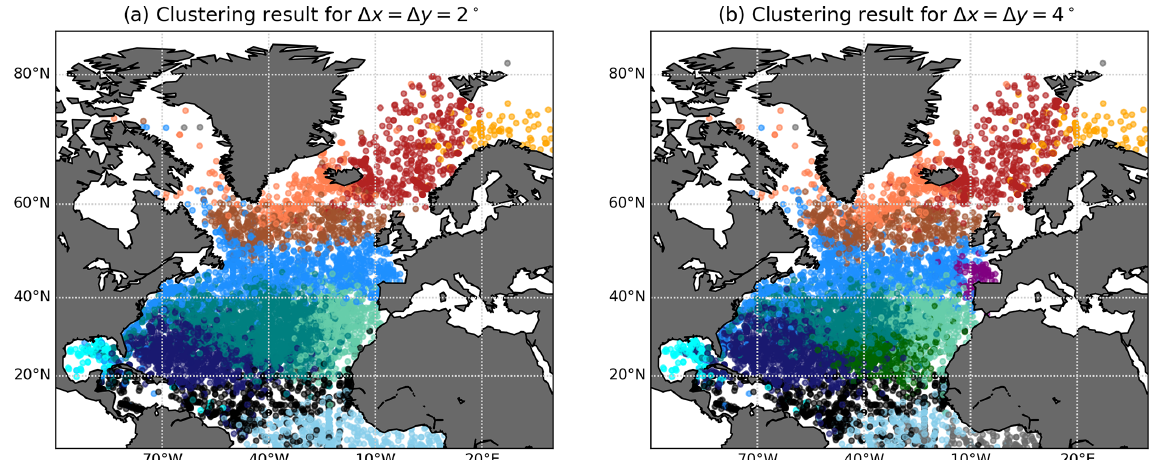
Figure C2. Clustering of Q for the drifter data set and different bin sizes, with trajectory lengths restricted to 1 year, 20 clusters as in Fig. 6, plotted at initial time and the drifter release location. (a) (cid:49)x = (cid:49)y = 2 ◦ . (b) (cid:49)x = (cid:49)y = 4 ◦ . The main features of Fig. 6 are still visible, although some structures change: the Bay of Biscay is not detected in (a) , and the structure of the clusters in the centre of the Subtropical Gyre change compared to Fig. 6. There are also new clusters in black (a, b) and dark green (b) . Note that the main features of the North Atlantic Ocean, such as the Subtropical–Subpolar Gyre boundary, the Western Boundary Current region, the Caribbean Sea and the Nordic Seas, are still detected; see the result in Fig.